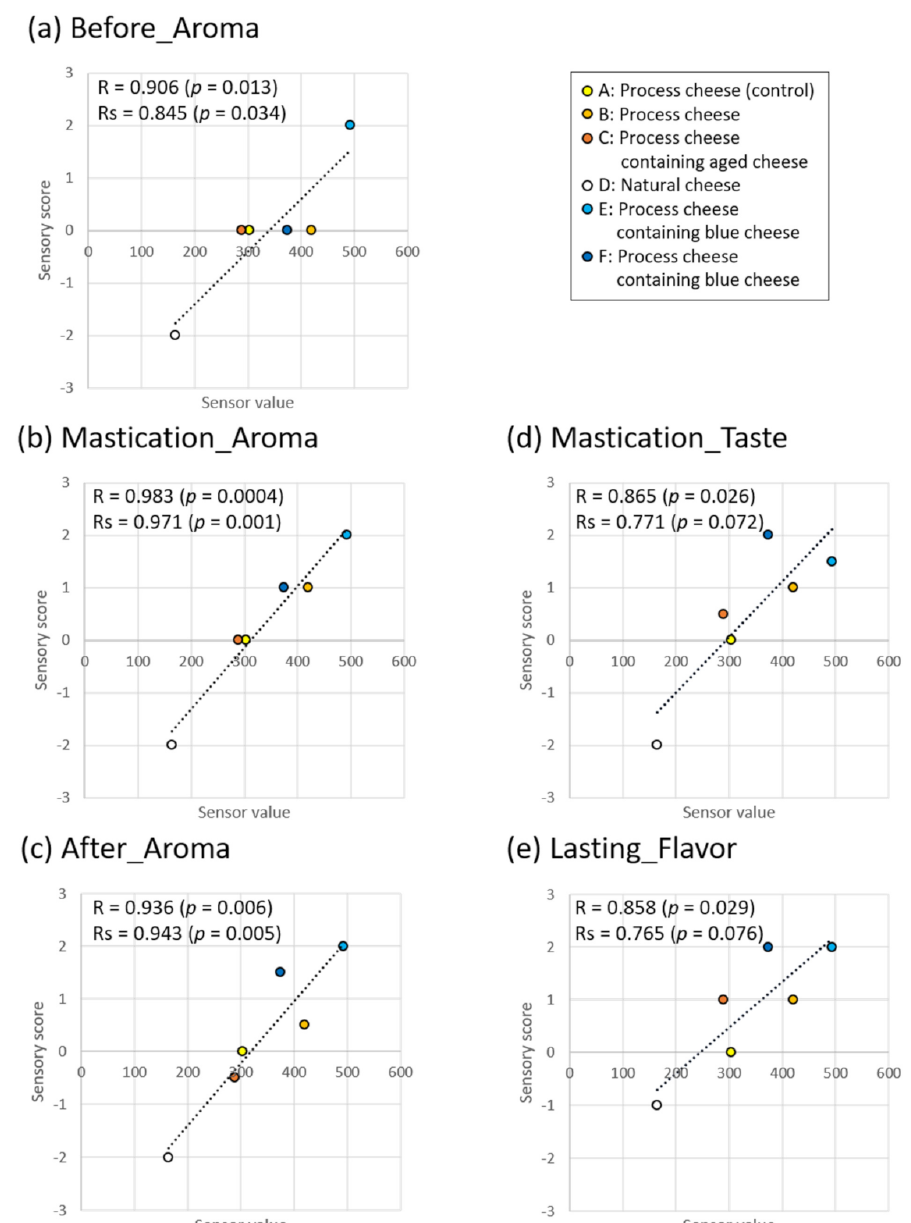
Figure 6. Correlation of electronic nose sensor values (mean values in Figure 5a) and sensory scores (median values in Figure 4). R: Pearson’s correlation coefficient. Rs: Spearman’s rank correlation coefficient. ( a ) Before_Aroma; ( b ) Mastication_Aroma; ( c ) After_Aroma; ( d ) Mastication_Taste; ( e )